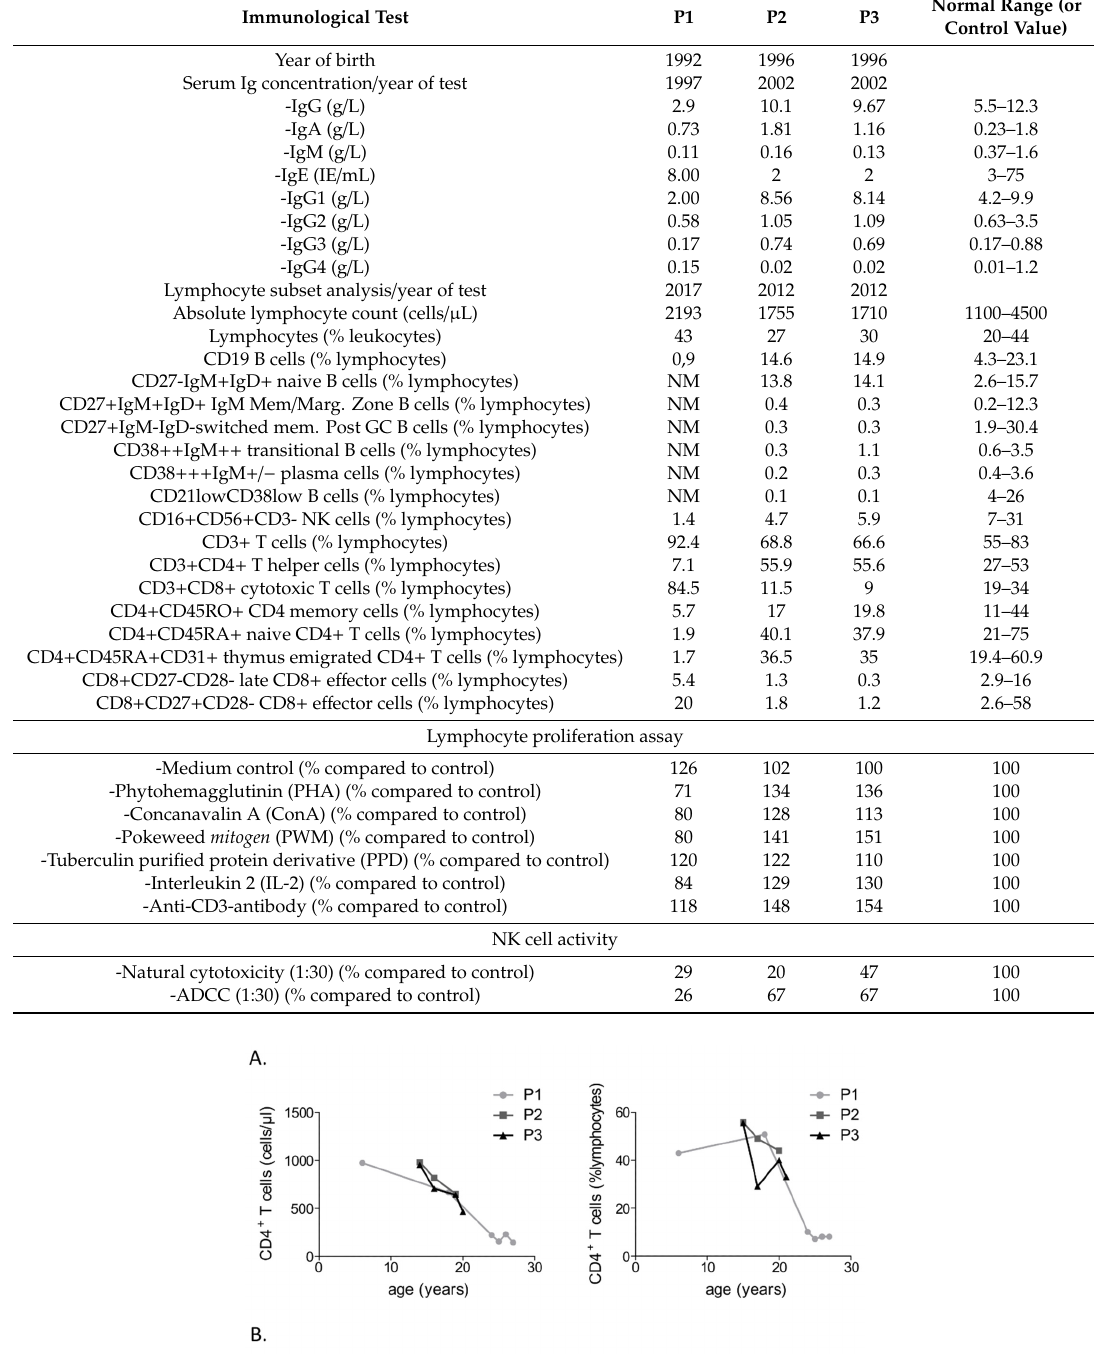
Table 2. Immunological findings in three patients with immunodeficiency, centromeric instability and facial anomalies syndrome 2 (ICF2).